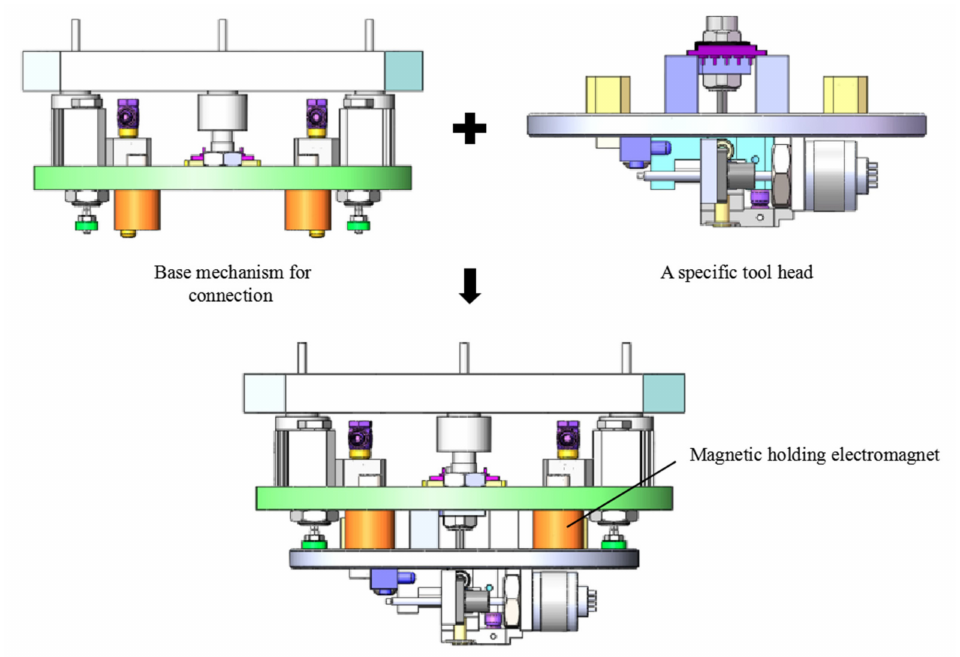
Figure 6. Schematic diagram of picking a specific tool head.